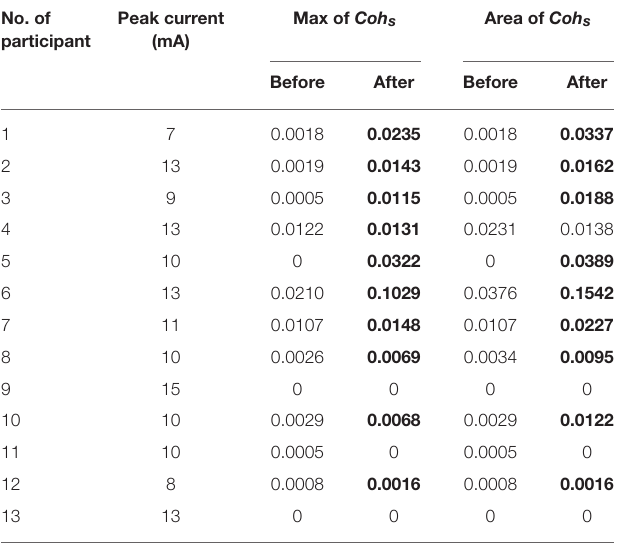
where K is the total number of